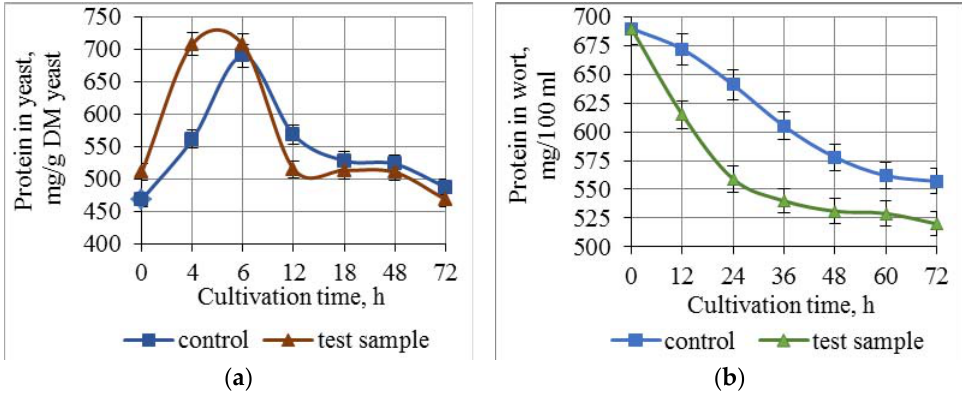
Figure 7. Amount of protein in yeast during cultivation ( a ) and in the culture medium ( b ). In panels ( a ) and ( b ), the values with a statistically significant difference ≤ 0.05 are shown.